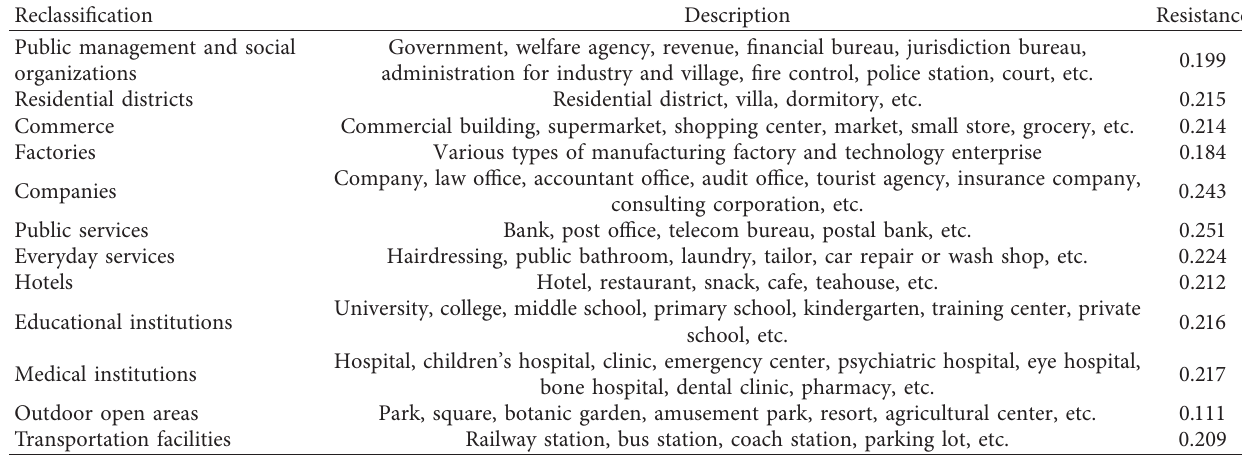
Table 3: Classification of urban functional elements and average resistance coefficients in